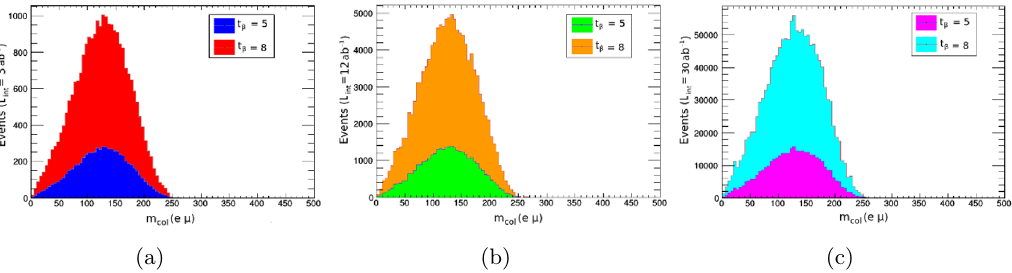
Figure 8 . Distribution of the collinear mass versus number of signal events for scenarios (a) SA , (b) SB and (c) SC